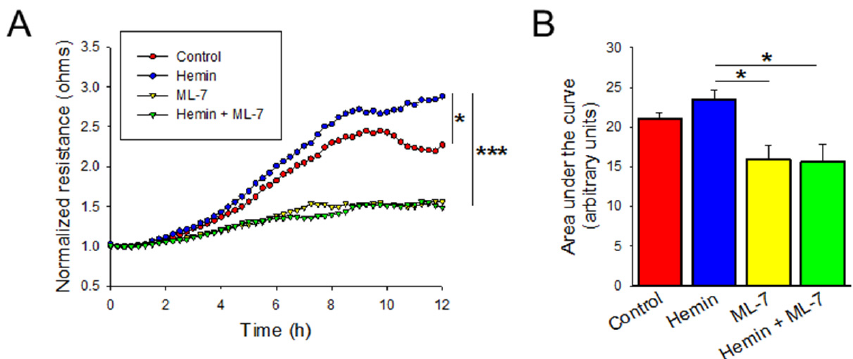
Figure 5. Hemin increases HPAEC migration which is abrogated by MLCK inhibition as measured by electric cell impedance sensing (ECIS). ( A ) Plot denoting the transendothelial resistance by ECIS-based wounding over time in HPAECs treated with PBS control, hemin (5 µM), PBS pre-treated with ML-7 (20 µM), and hemin pre-treated with ML-7 (20 µM) ( n = at least 4). ( B ) Bar graph denoting area under the curve measurement for ECIS-based wounding experiments at 12 h ( n = at least 4). * indicates p < 0.05; ***, p < 0.001; ML-7, myosin light chain kinase specific inhibitor.